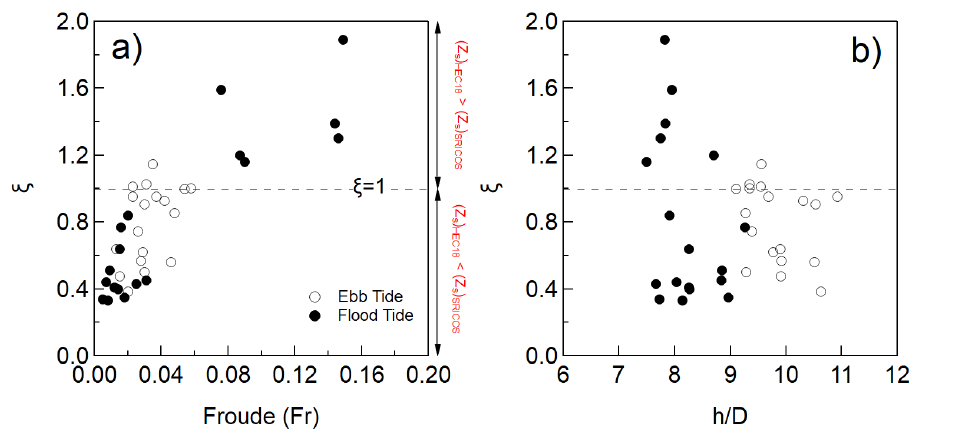
Figure 15. Distribution of parameter ξ for flood-tide and ebb-tides acting at North Tower site, versus ( a ) the mean Froude ( Fr ) number and ( b ), the relative depth h / D , where h is the mean flow depth around each pier and D the diameter. The horizontal dashed line corresponds to ξ =